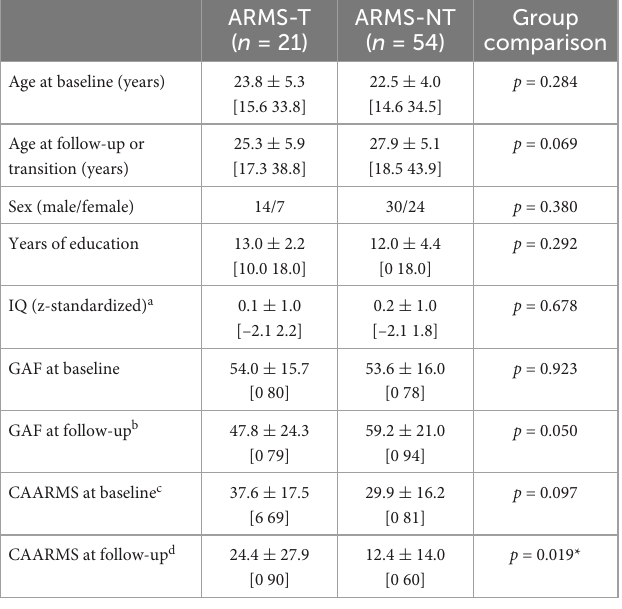
TABLE 2 Socio-demographic and clinical information of the At Risk Mental State (ARMS) sample with genetic data and an European ancestry.